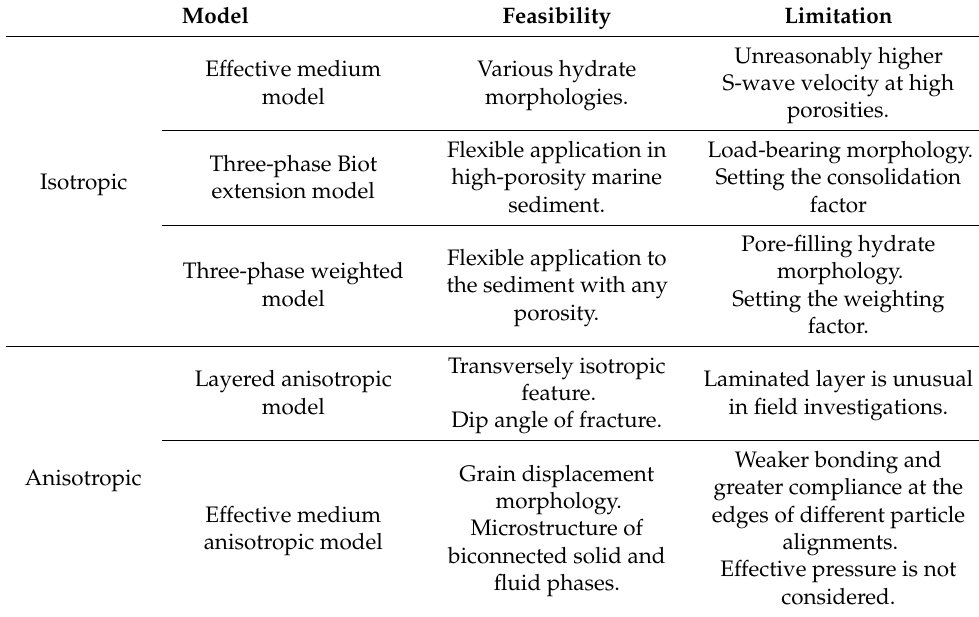
Table 1. Feasibility and limitation of the various rock physics